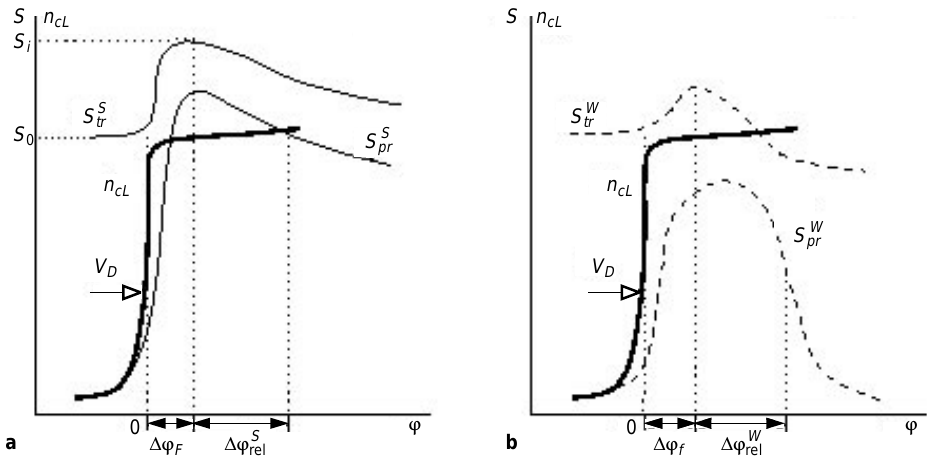
Fig. 1a, b. Qualitative pictures of the energetic particle precipitation pattern during a magnetic storm in cases of a strong and b weak di(cid:128)usion. S tr and S pr are the fluxes of the trapped and precipitated energetic electrons as measured by a low-altitude satellite; (cid:117) is the coordinate along the energetic electron drift velocity v D ; n cL is the cold plasma density in the equa- torial plane. Superscripts S and W refer to the strong and weak pitch angle di(cid:128)usion regimes,